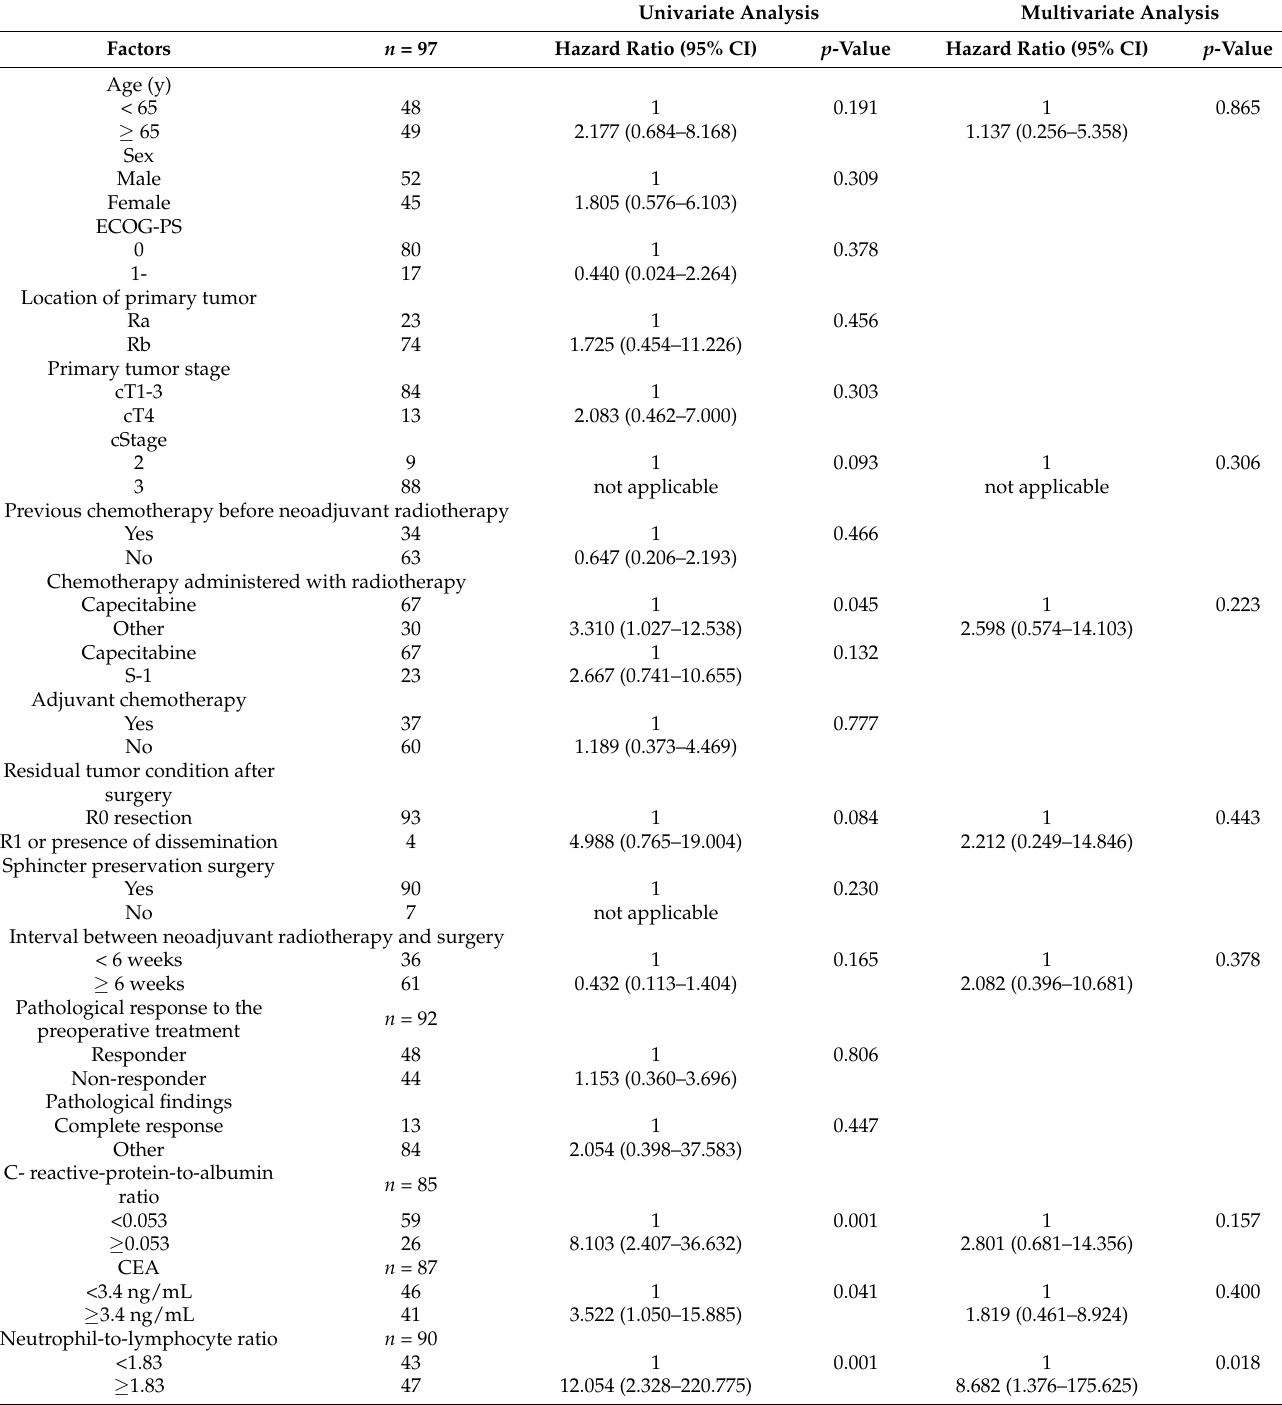
The ROC curve indicated cut-off values of 0.053, 3.4, and 1.83 for C-reactive-protein- to-albumin ratio (CAR), carcinoembryonic antigen (CEA), and neutrophil-to-lymphocyte ratio (NLR), respectively (Supplemental Figure S1). Univariate analyses revealed that the following factors were significantly associated with poor OS: no concurrent administration of capecitabine, high CAR, high CEA level, and high NLR (Table 5, Figure 2). Multivariate analysis indicated that high NLR was independently associated with poor OS. Table 5. Univariate and multivariate analyses for the factors associated with overall survival. Univariate Analysis Multivariate